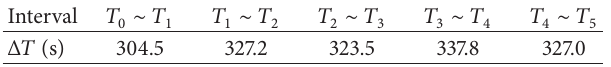
Table 4: Flight time in each trajectory interval (Case 1).